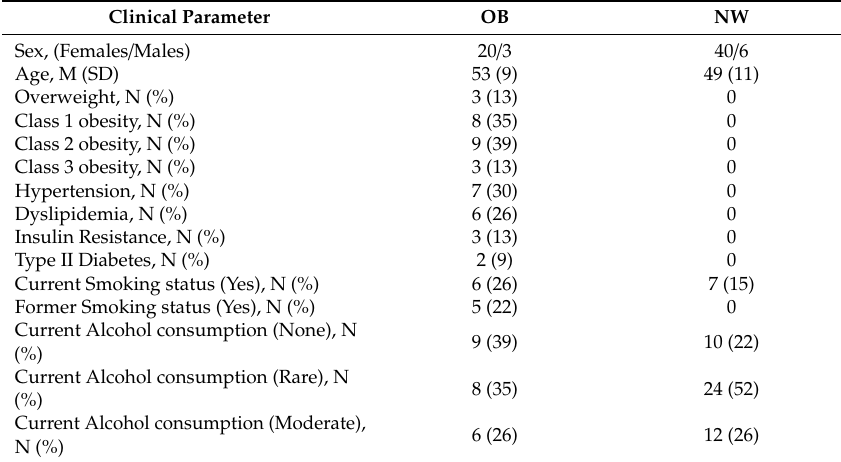
Table 1. Clinical characteristics of the recruited